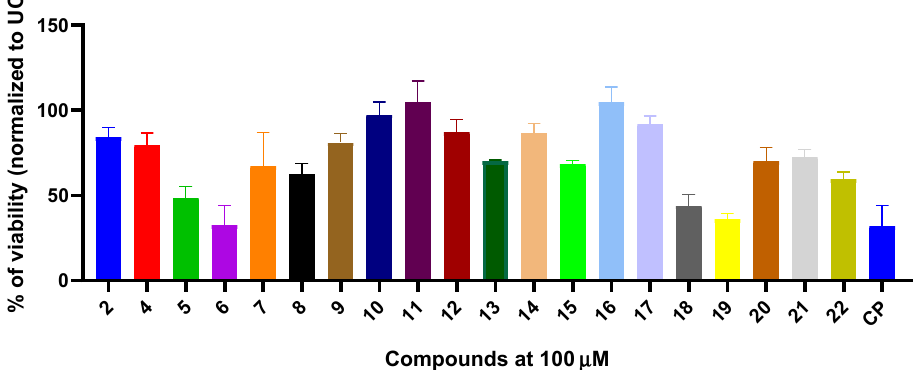
Figure 3. The in vitro cytotoxic activity of 5-oxopyrrolidine derivatives 2 and 4 – 22 on non-cancerous HAEC1-KT human small airway epithelial cells. The cells were exposed to 100 µM of each compound or cisplatin (CP) for 24 h and post-treatment viability was calculated using untreated control as a normalization marker. Data are shown as mean ∓ SD from 3 experimental replicas.